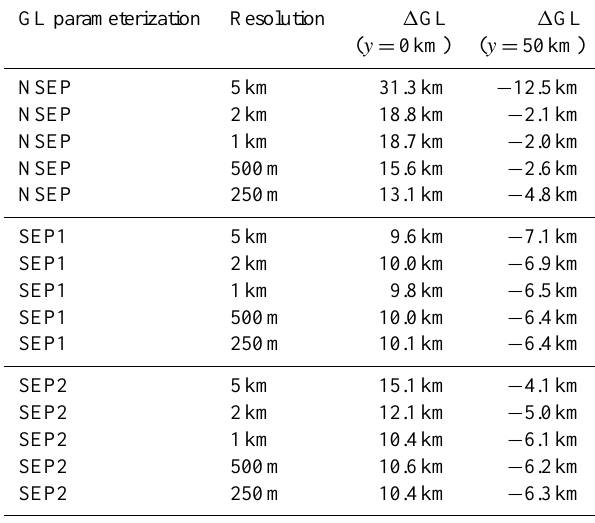
Table 2. Grounding line displacement during the perturbation ex- periment for the 15